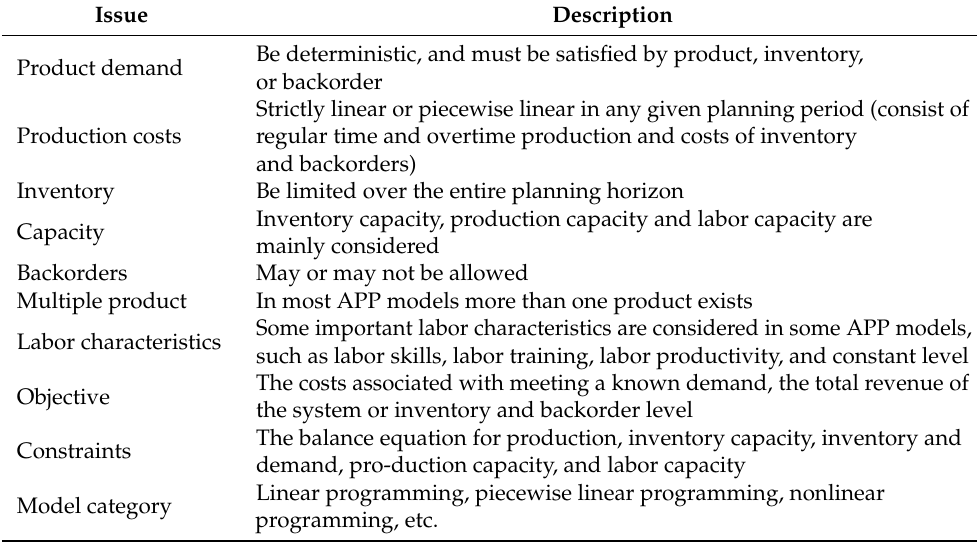
Table 2. The characteristics of the existing